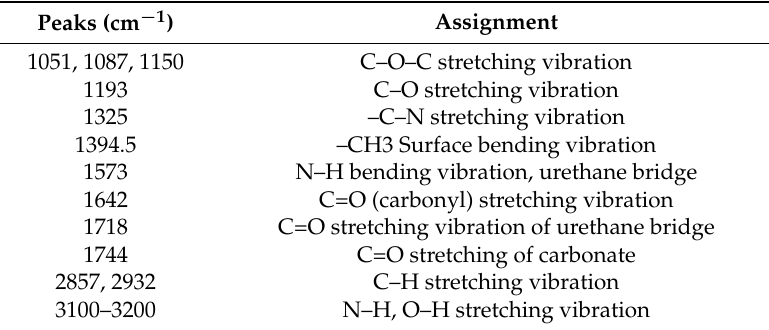
Figure 19. FTIR spectra of sucrose, carbonated sucrose B1, and sucrose-based B2 NIPU resin. Table 2. FTIR peak